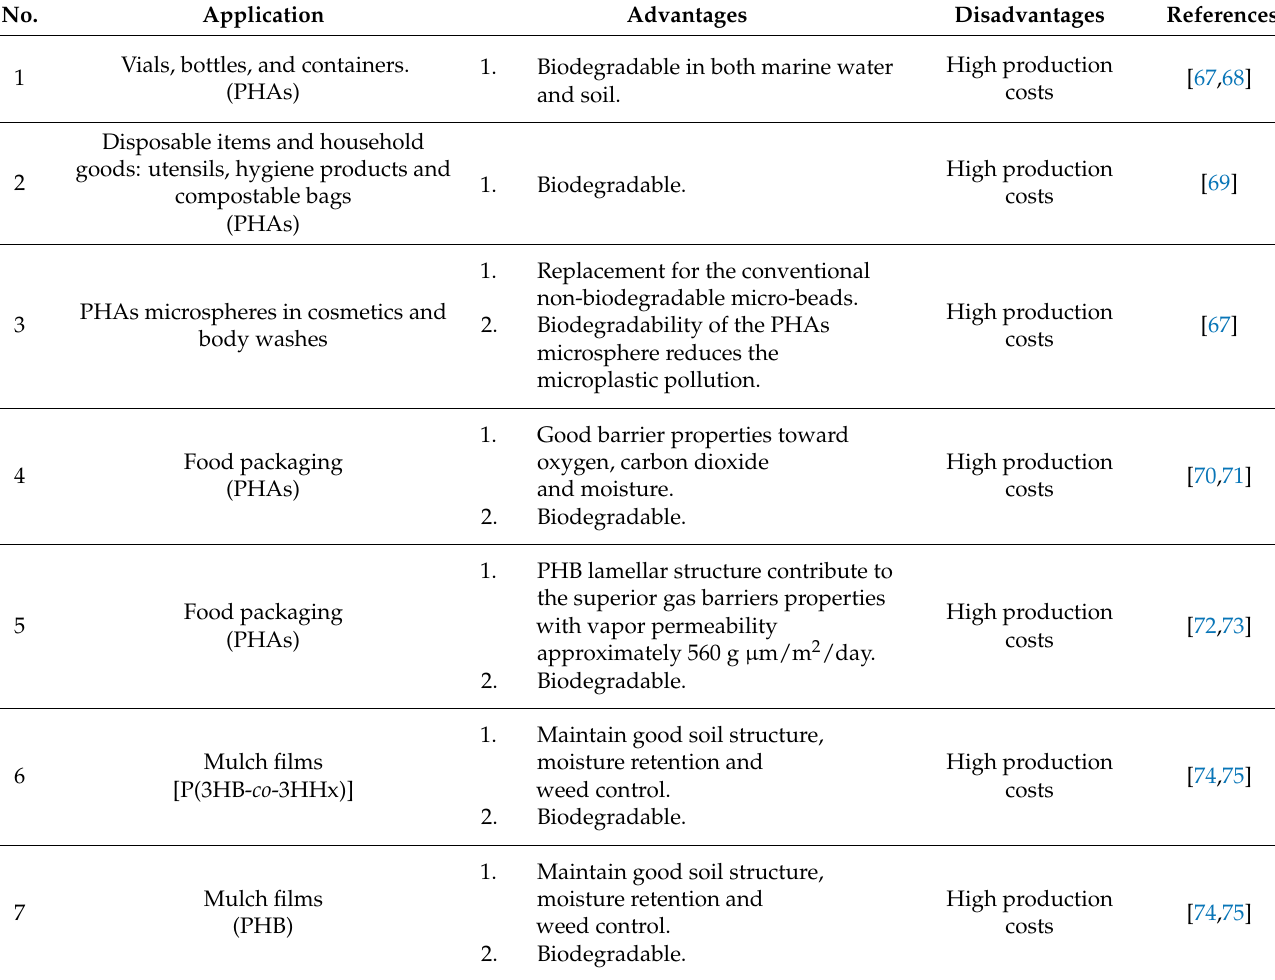
Table 2. Summarization of PHA-based